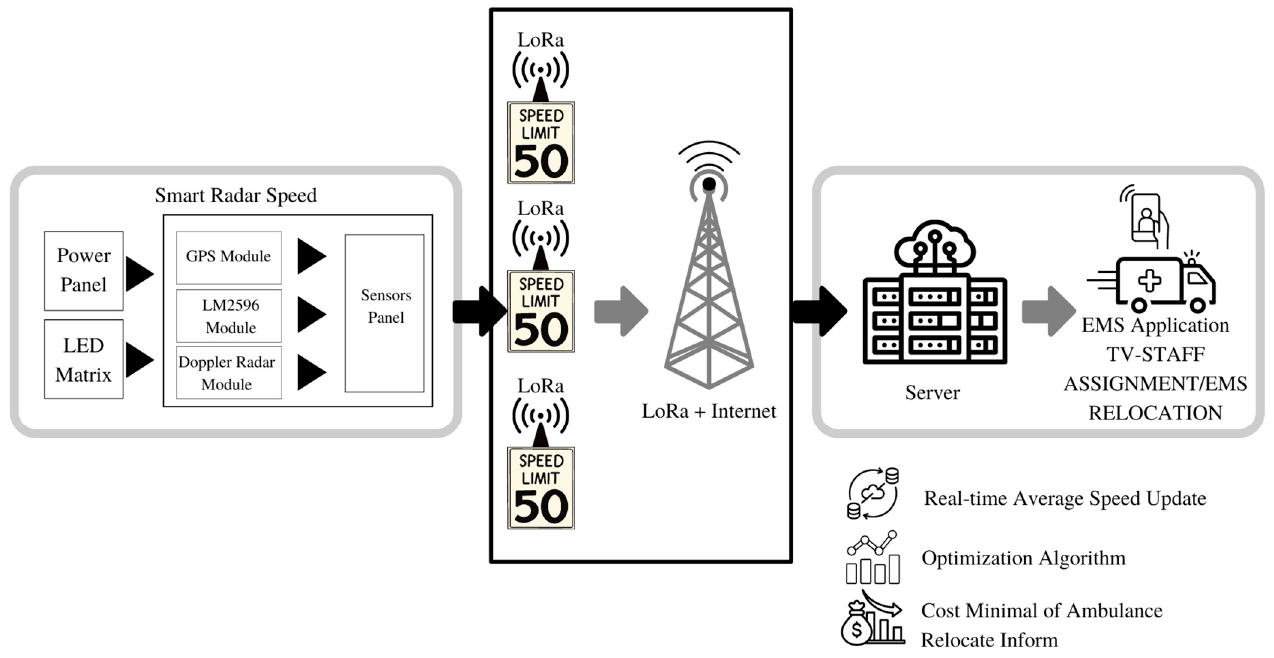
Figure 1. Framework of the proposed